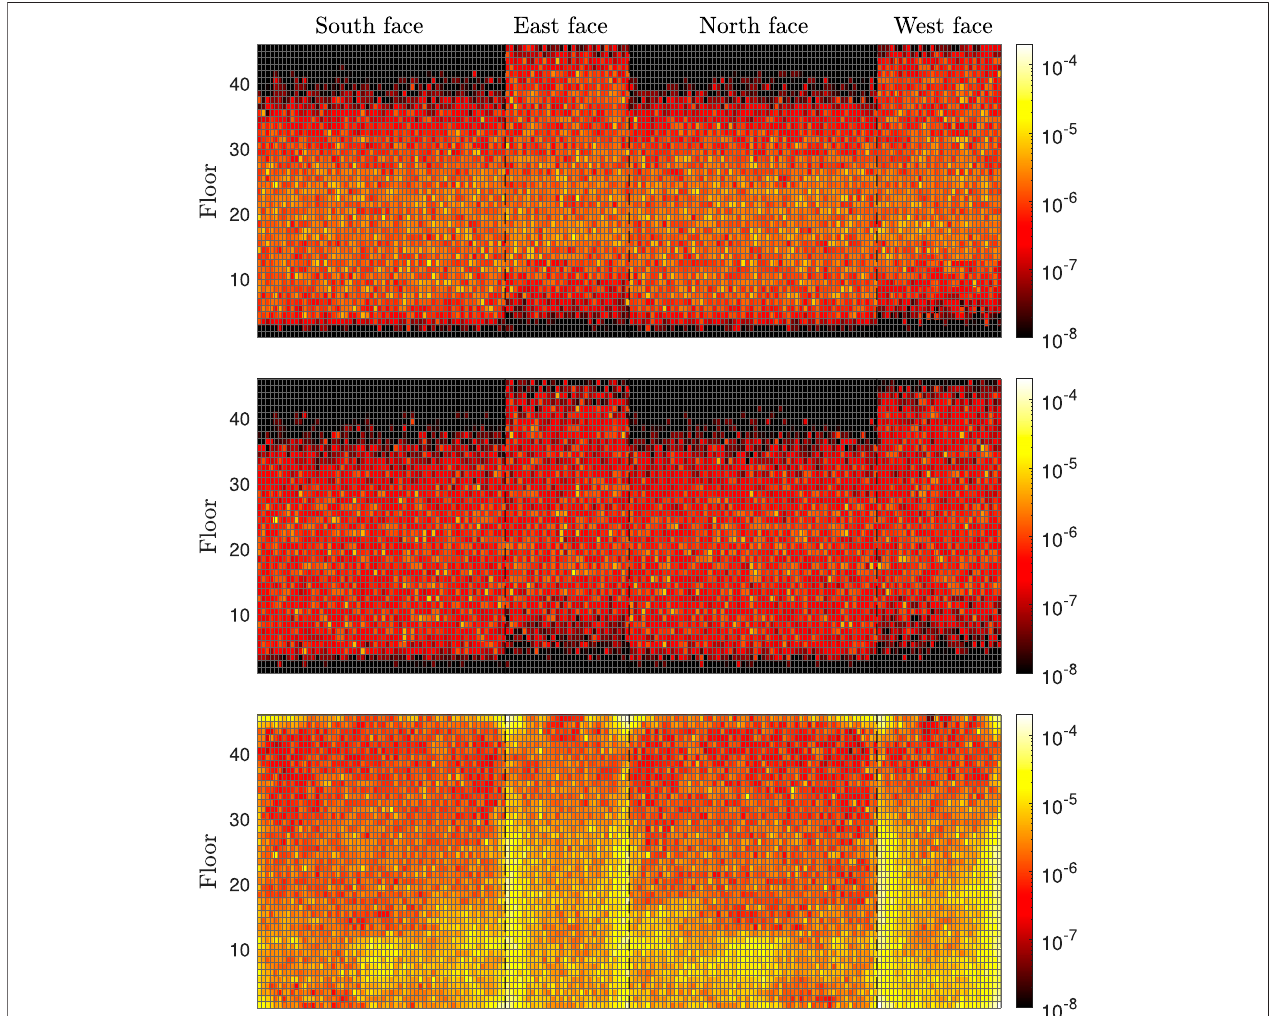
FIGURE 8 | Mean annual rate of each envelope component assuming as a fi nal damage state DS Dr , and bottom panel with DS P panel with DS Dr 2 60